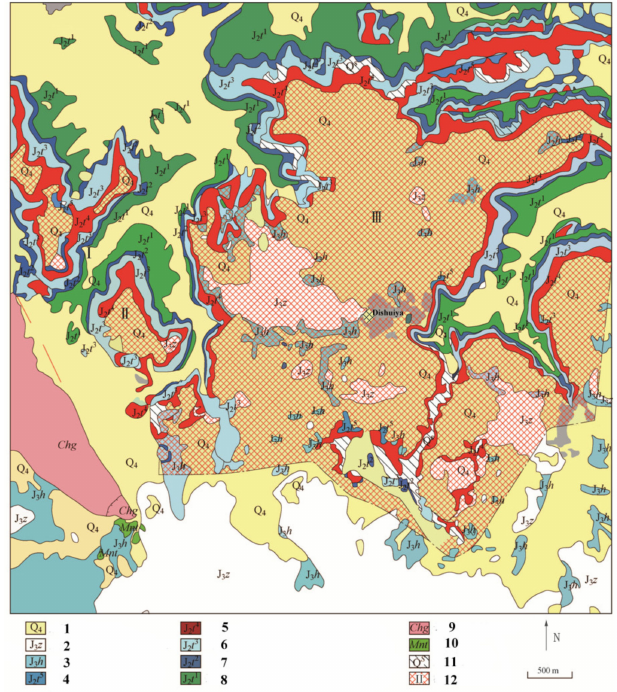
Figure 1. Geological map of Xuanhua agate deposit and its adjacent areas (modified after [17]): 1 Quaternary loess; 2 rhyolitic tuff; 3 siltstone; 4 agglomerate tuff and tuffaceous breccias; 5 vesicular trachyte; 6 massive trachyte; 7 tuffaceous siltstone and volcanic breccias; 8 basalt; 9 dolomite of the Mesoproterozoic Changcheng formation; 10 bentonite deposit; 11 Qml; 12 agate-bearing zones and their number.